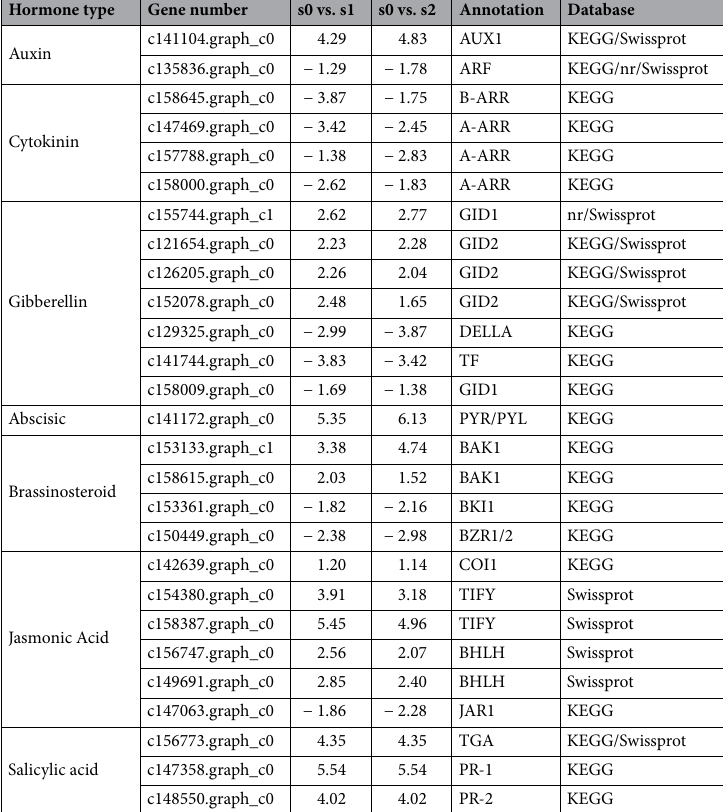
Table 2. Hormone-related common DEGs (log2FC) of larch in the two